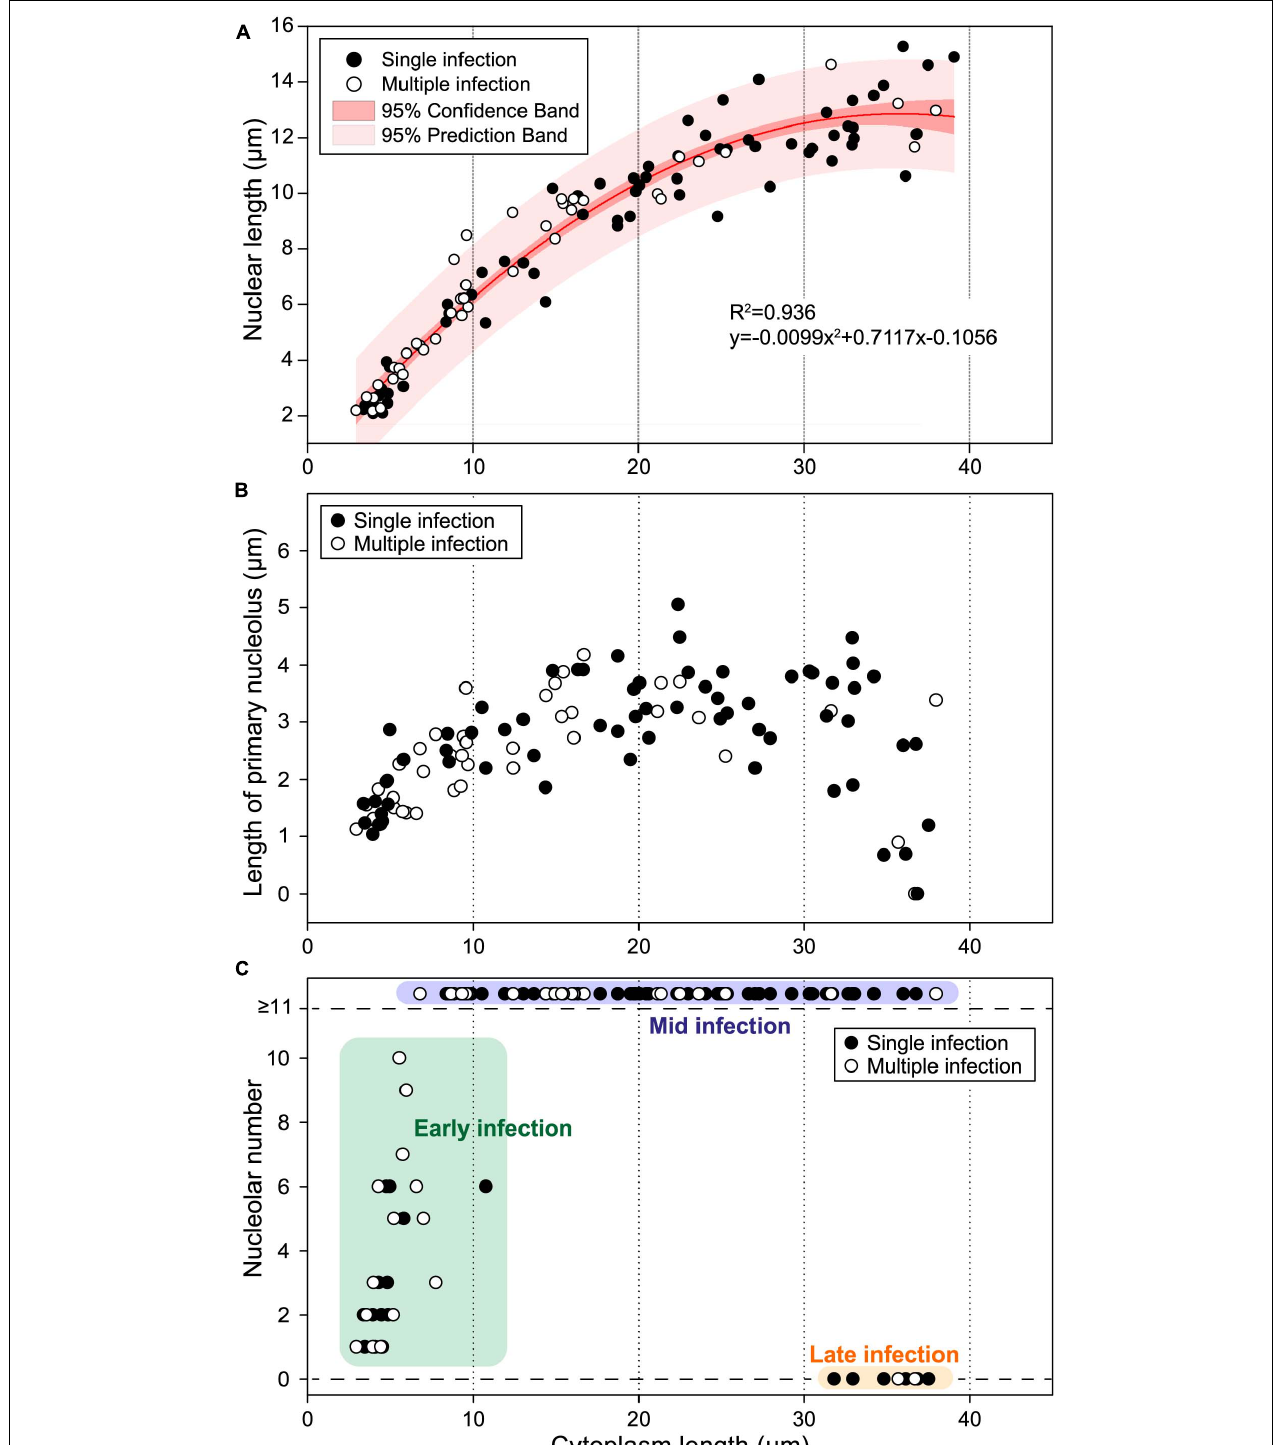
FIGURE 5 | Nuclear size, primary nucleolar length, and nucleolar number relative to cytoplasm size for protargol-stained trophonts of Euduboscquella triangula . (A) Nuclear size positively correlated to cytoplasm size ( R 2 = 0.936). Single infection (filled circle), multiple infection (open circle), 95% confidence interval (dark pink band), 95% prediction interval (light pink band). (B) Primary nucleolus gradually increased in size during early to mid-stage, but began to decrease during the late stage. (C) Infections classified into three stages depending on the number and developmental state of nucleoli: early infection (green box), mid infection (purple box), and late infection (orange